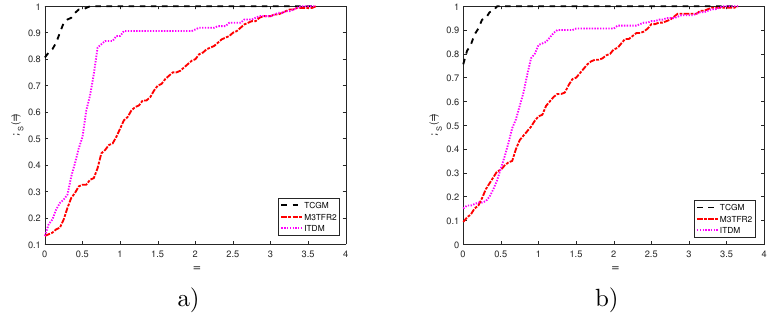
Figure 2. Results of numerical experiments: a) function evaluations performance profile b) CPU time performance